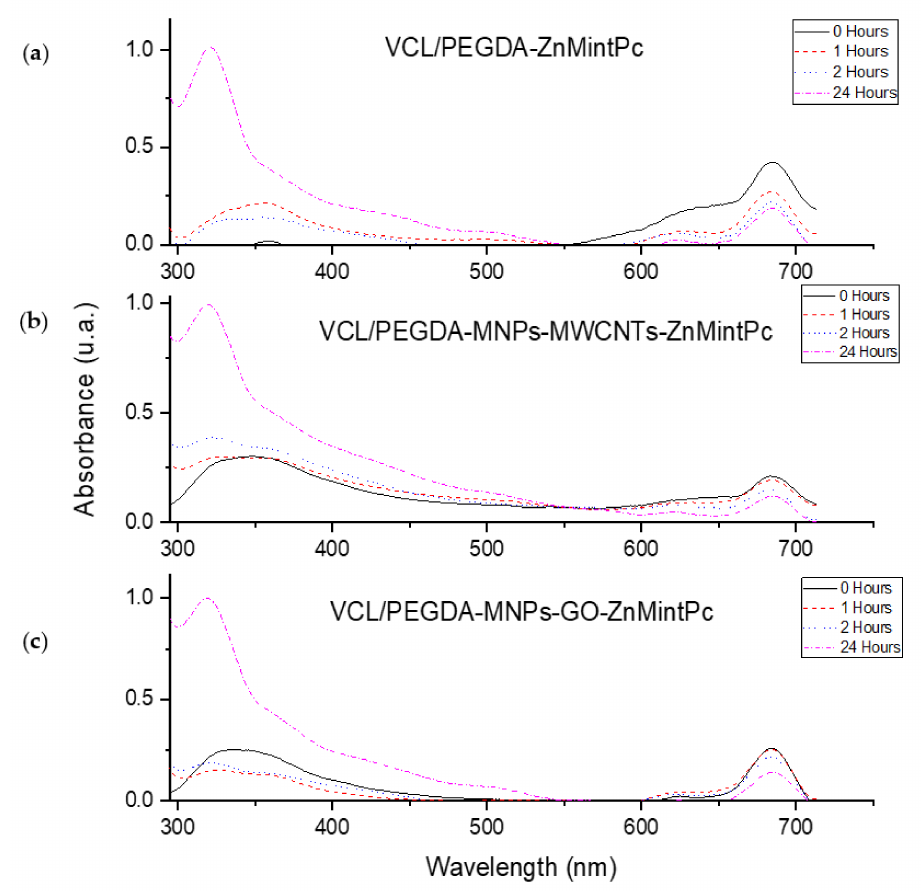
Figure 4. Stability curves over time for ( a ) VCL-PEGDA-ZnMintPc; ( b ) VCL/PEGDA-MNPs-